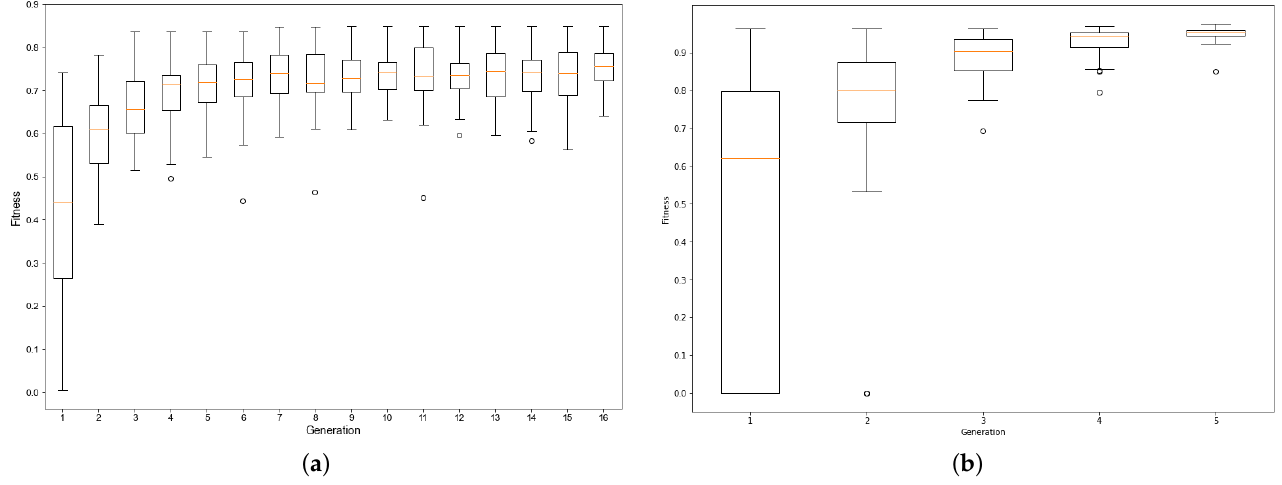
Figure 8. Box plot of the fitness evolution training ANN with: ( a ) Levenberg–Marquardt backpropa- gation, ( b ) Bayesian regularization